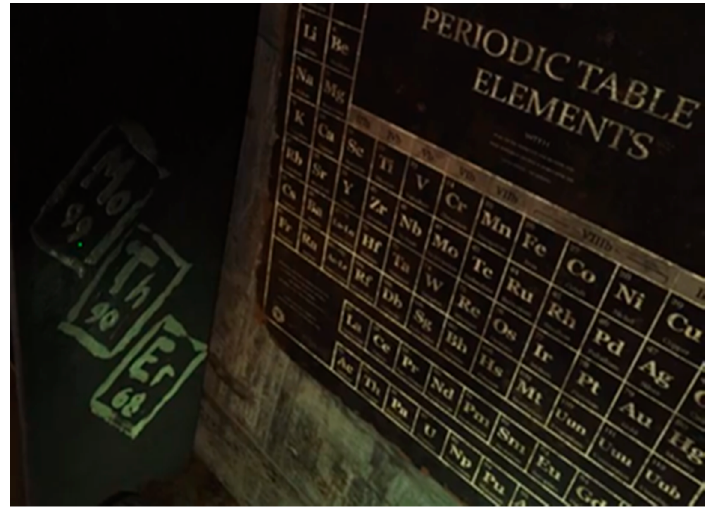
Figure 6. The Periodic Table that serves as the holy text of the Church of the Children of Atom.